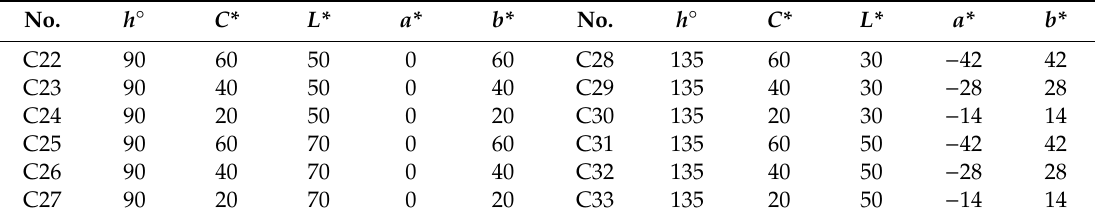
Table 3. Color element values of the representative train seat color sample